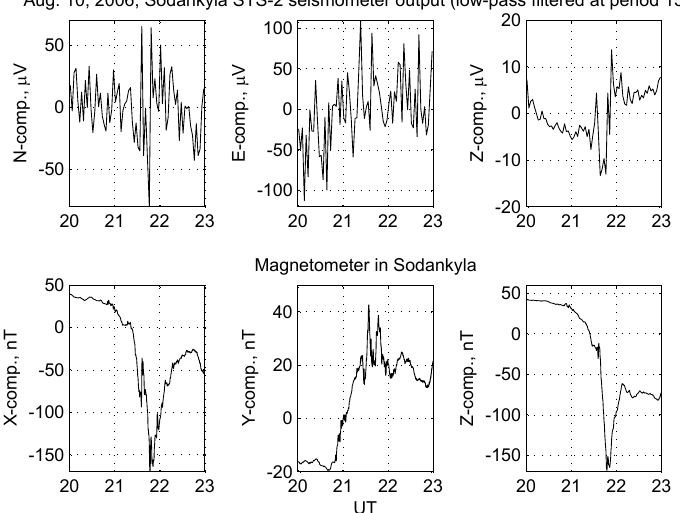
Fig. 2. An example of magnetic substorm recorded by co-located magnetometer and STS-2 seismometer in Sodankyl¨a. Top panels show the 3-components (north, east, and vertical) of the seismometer output. The data were low-pass (at 150s) filtered. Bottom panels present variations in the corresponding three components ( X , Y , and Z , respectively) of the magnetic field.